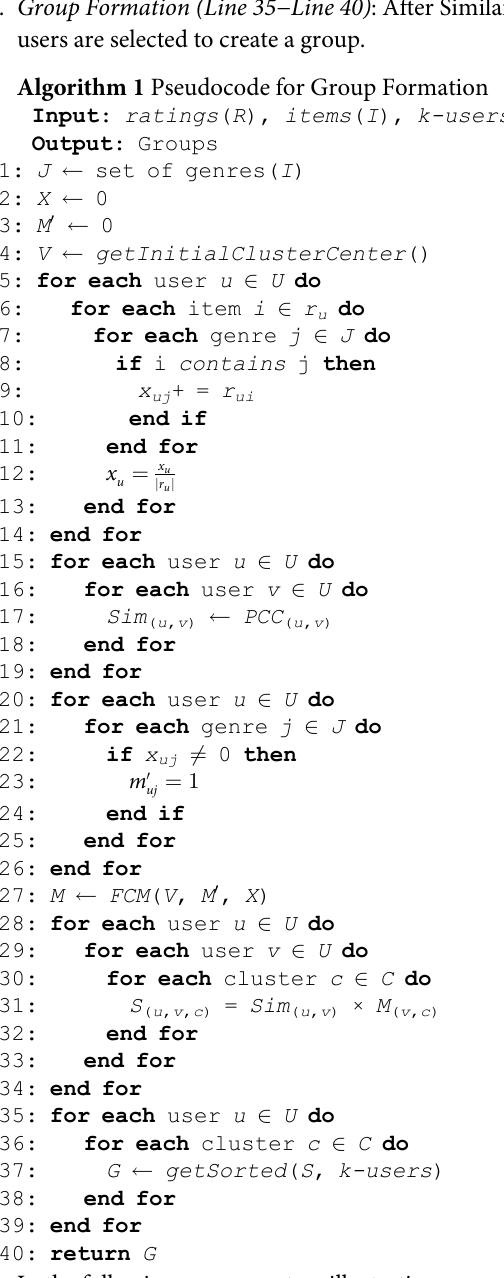
Algorithm 1 Pseudocode for Group